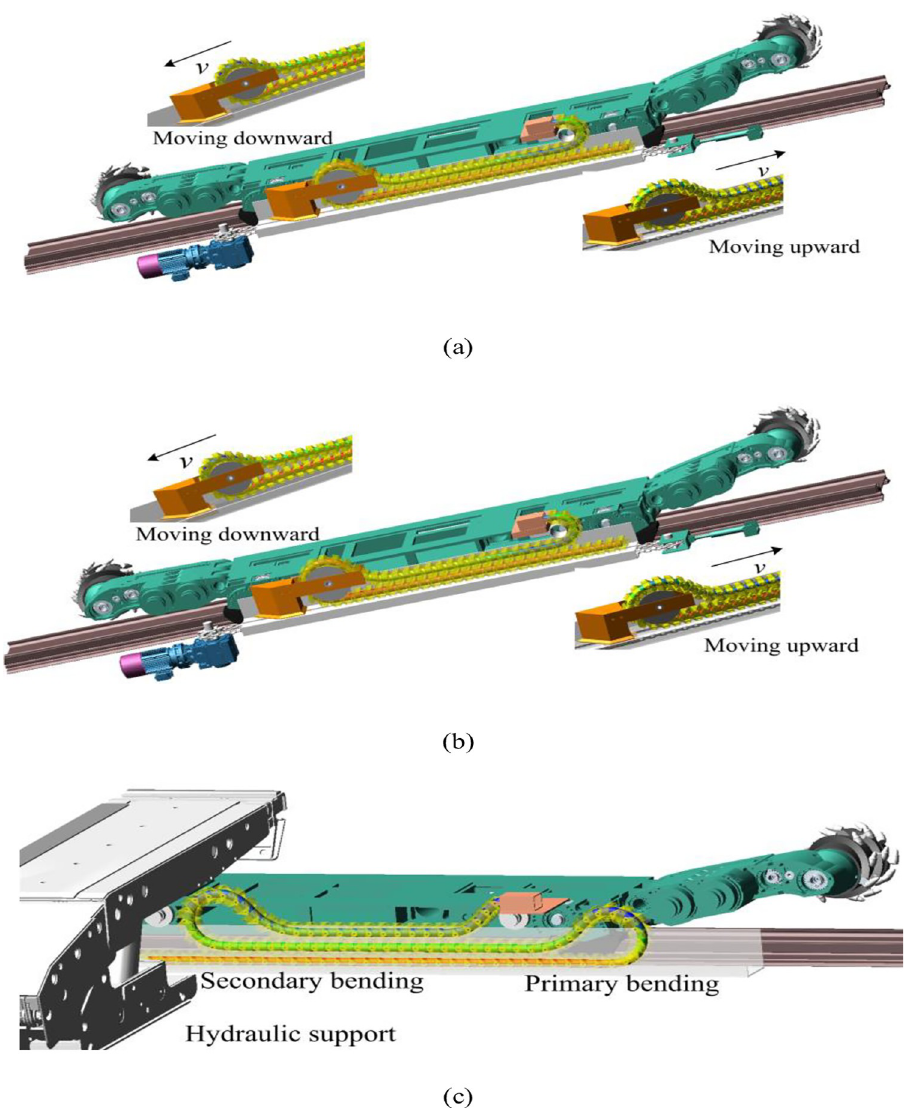
Fig 16. Dynamics simulations: (a) intelligent towing at horizontal working surface; (b) towing upward and downward at large inclination; (c) conventional towing at horizontal working surface.